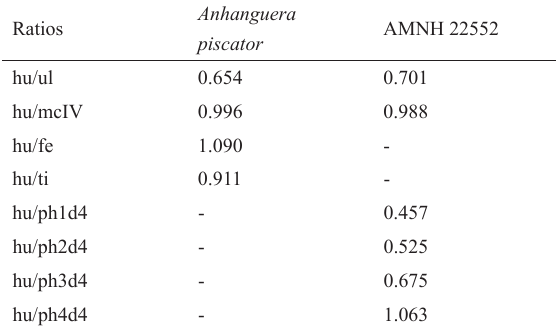
Anhanguera piscator (NSM-PV 19892) and AMNH 22552 ratios based, respectively on the measurements presented by Kellner and Tomida (2000) and Wellnhofer